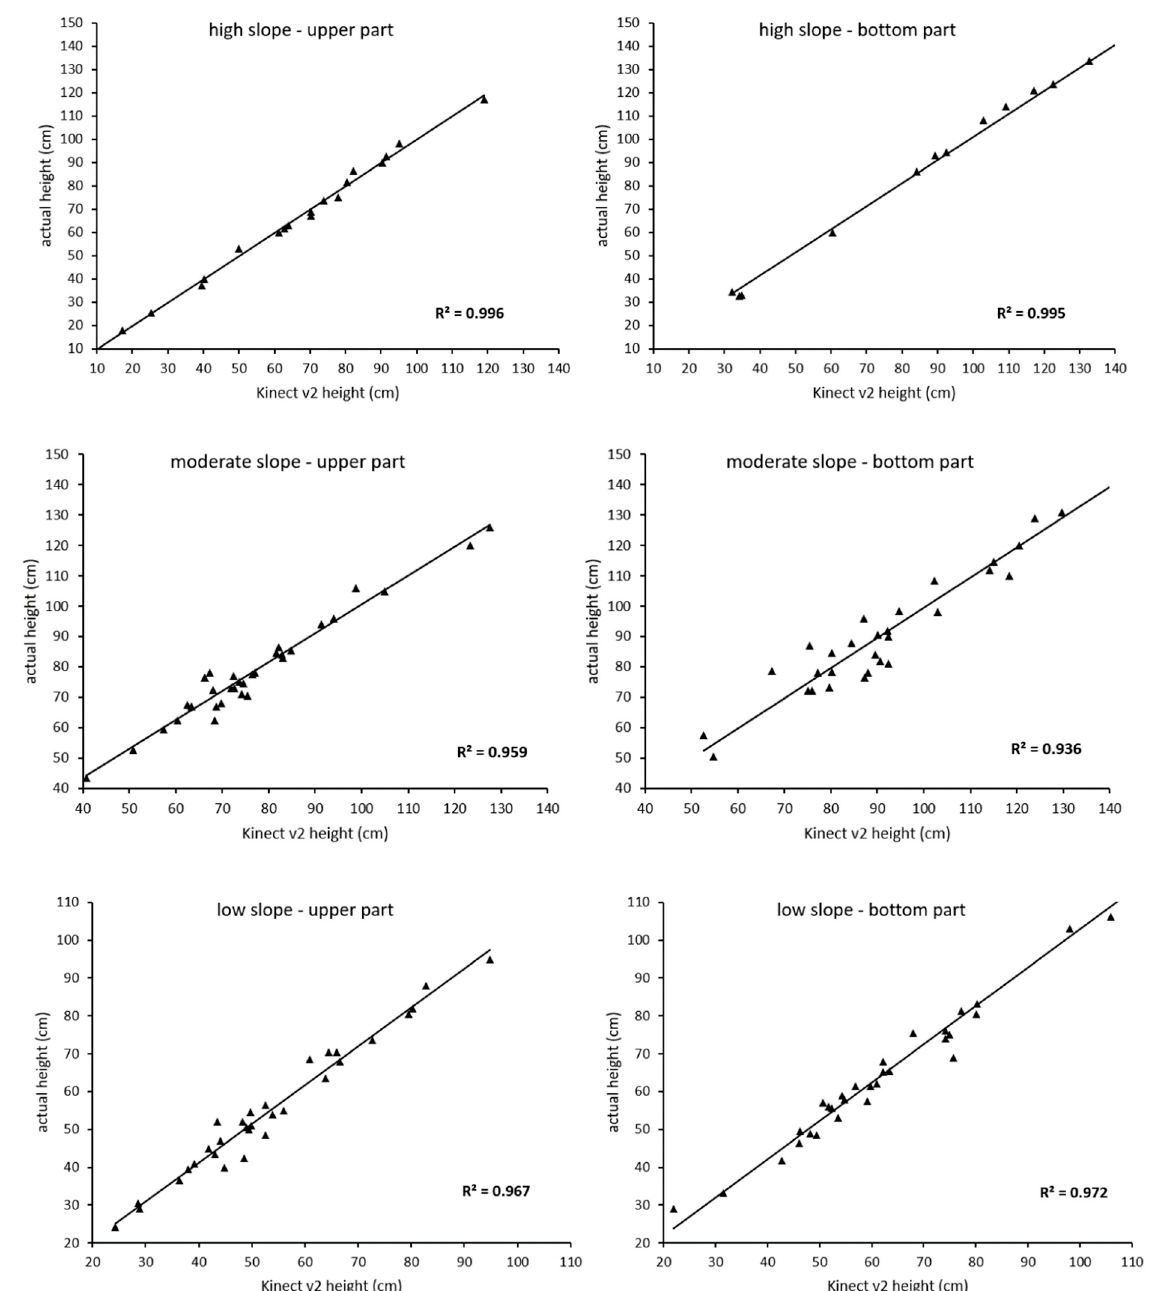
Figure 4. Kinect v2 height versus actual height (ground truth), including the effect of the slope gradient according to a high, moderate, and low degree.